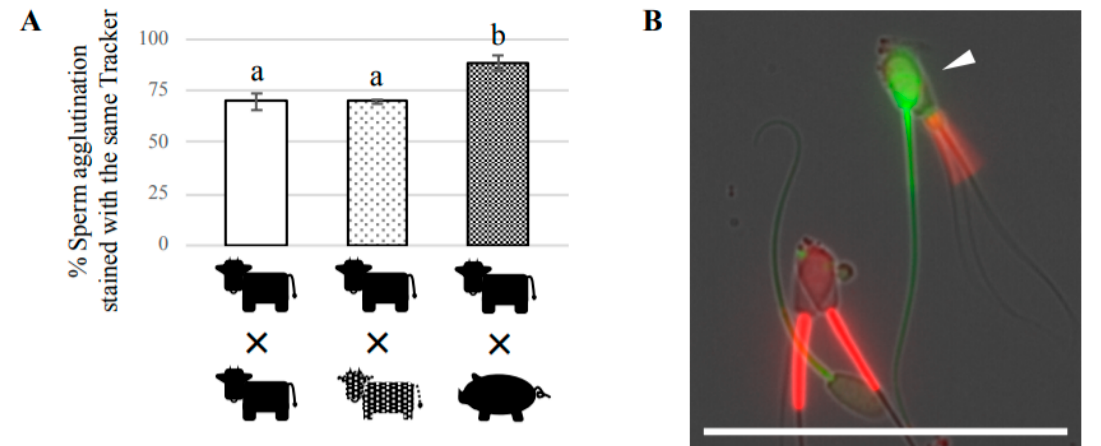
Figure 2. Evaluation of head-to-head agglutination of two sperm. ( A ) The percentage of two-sperm agglutination stained with the same tracker. Two sperm suspensions were separately stained with CellTracker Green or MitoTracker Red before coincubation. After washing, the same amount of sperm suspension stained with different tracker was mixed together, and co-incubated for 1 h. At least 100 two-sperm agglutinations were counted for each group. Data are shown as the mean ± SE ( n = 3). Different letters indicate a significant difference ( p < 0.05). ( B ) Representative superimposed image showing flagellar beating of two-sperm agglutination composed of bovine and boar sperm. Green: CellTracker (Boar sperm); Red: MitoTracker (Bovine sperm). Bar = 50 μ m.